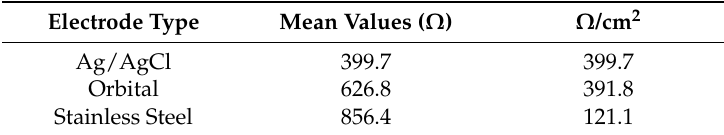
Table 4. Ag/AgCl, Orbital and stainless steel electrodes’ circuit component R s average values ( Ω ) for all the tested